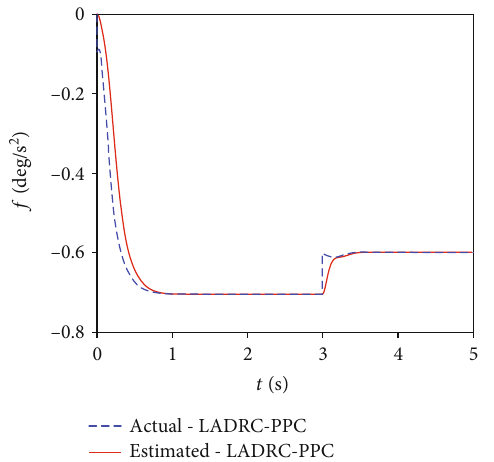
Figure 19: CT of Monte Carlo.